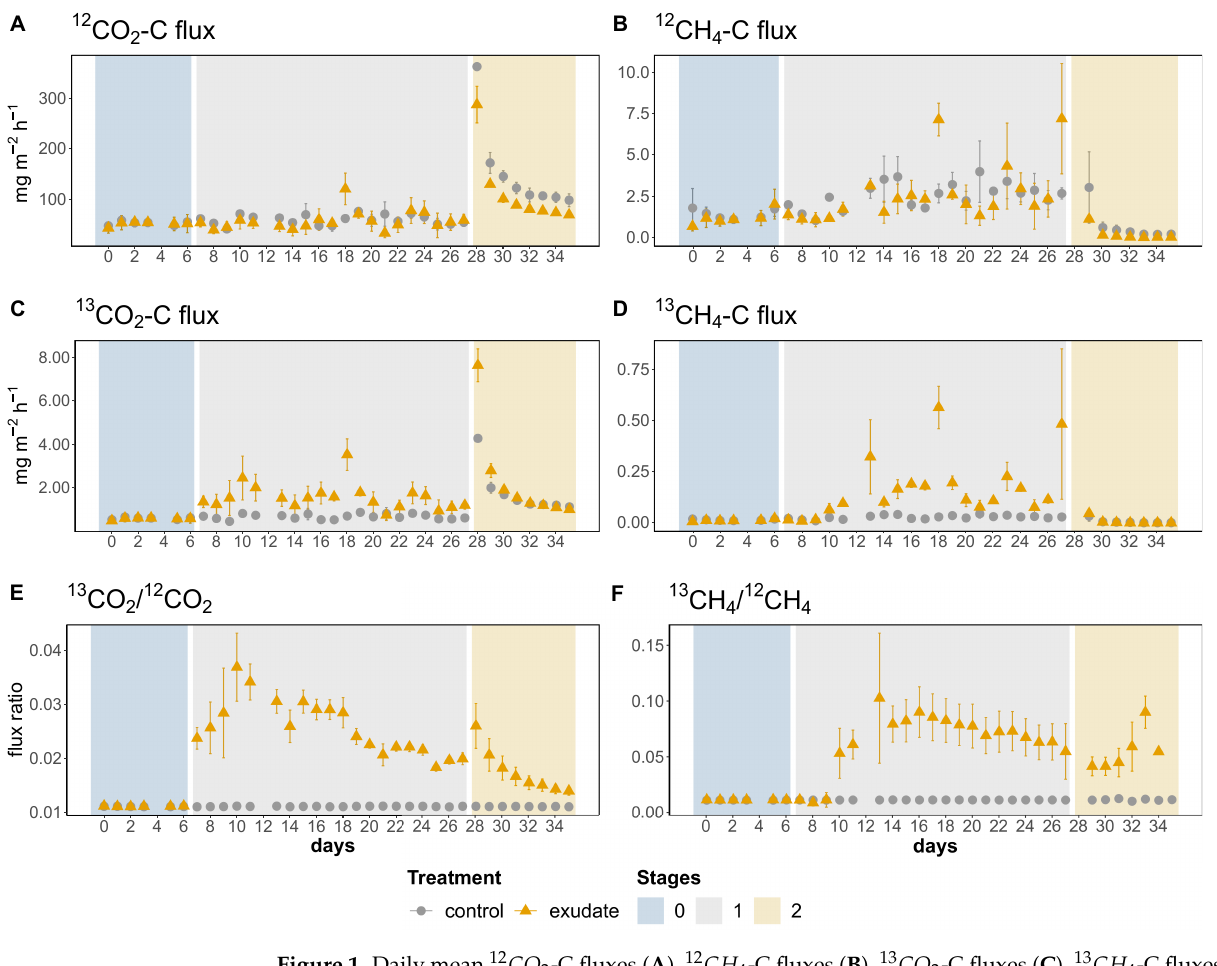
Figure 1. Daily mean 12 CO 2 -C fluxes ( A ), 12 CH 4 -C fluxes ( B ), 13 CO 2 -C fluxes ( C ), 13 CH 4 -C fluxes ( D ) and stable isotopic flux ratios of CO 2 ( E ) and CH 4 ( F ) for experimental stages (mean values, error bars indicate SE). Colored backgrounds indicate experimental stages (0: pre-treatment phase; 1: treatment phase; 2: drainage